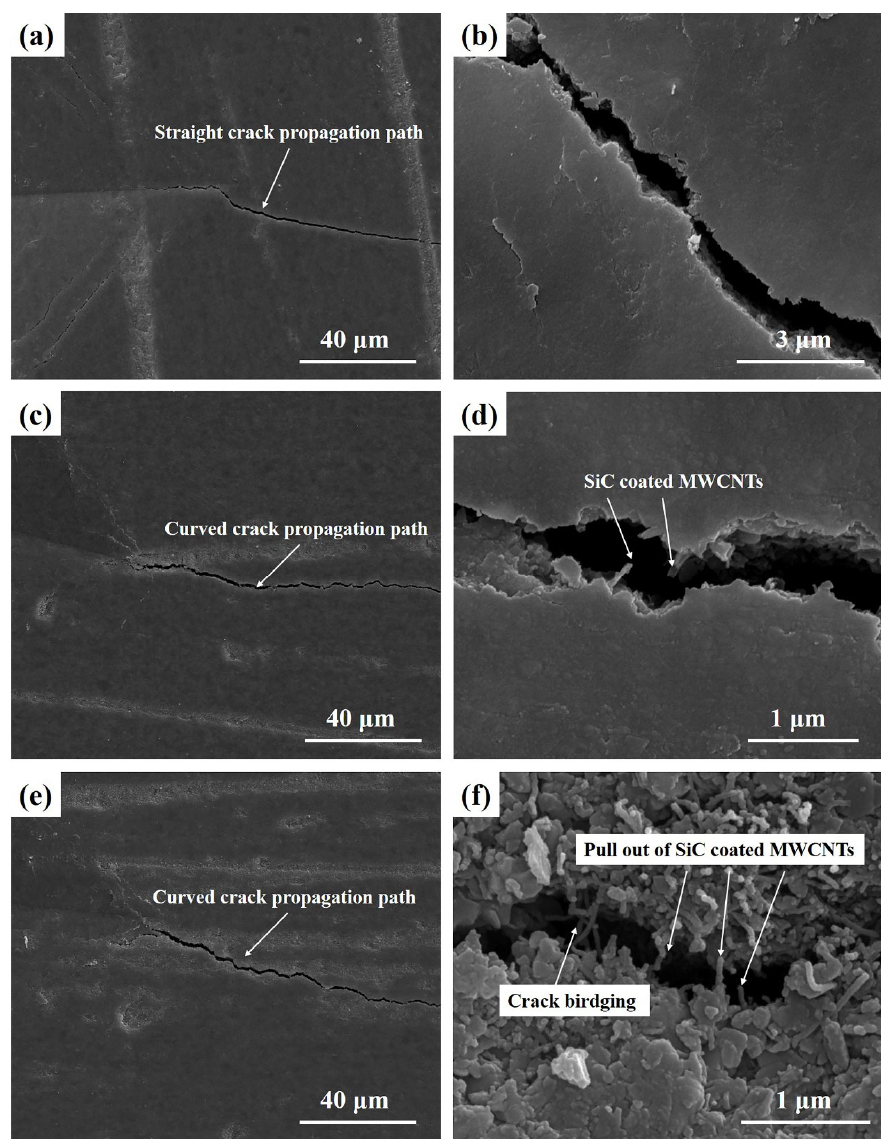
Fig. 6 Crack propagation paths after an indentation test: (a, b) SCNT0; (c, d) SCNT1; (e, f)